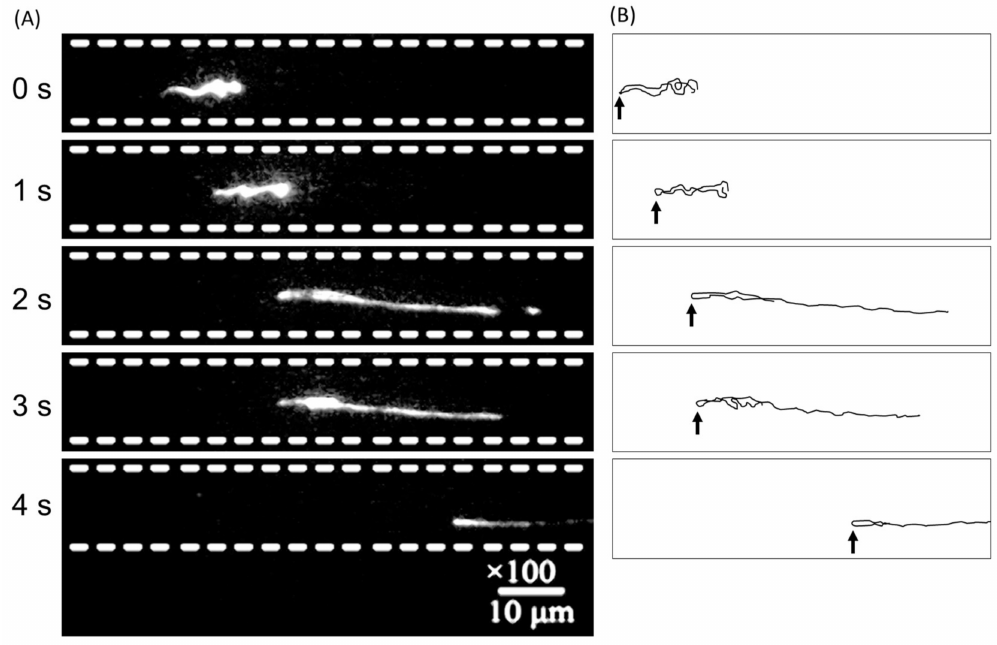
Figure 5. ( A ) Electrophoretic migration behavior of a single T4 DNA molecule in a 100 nm wide and 100 nm deep nanochannel, which is arrayed continuously side-by-side with 400 nm spacing inside dashed white lines. An electric field of around a few V/cm was applied horizontally along the nanochannels. ( B ) Presumed DNA conformation is depicted as a black line in the right for clarity. The folded and twisted parts, indicated by arrows, could be caused by defects in the silicon dioxide layer during anodic bonding. The DNA molecule appears to switch the nanochannel vertically during